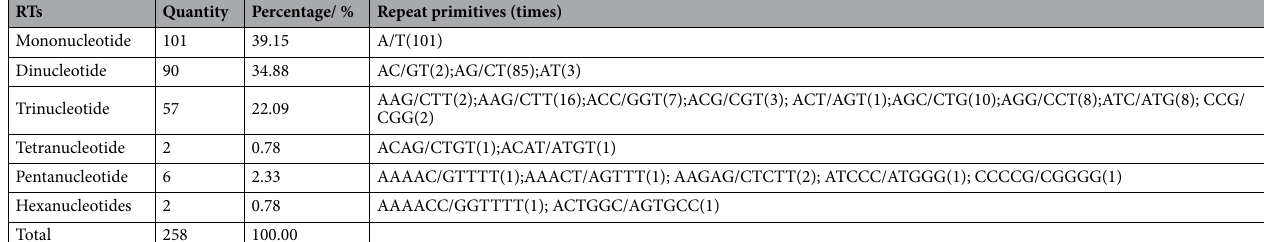
Table 1. Distribution tables of different types of repetition.